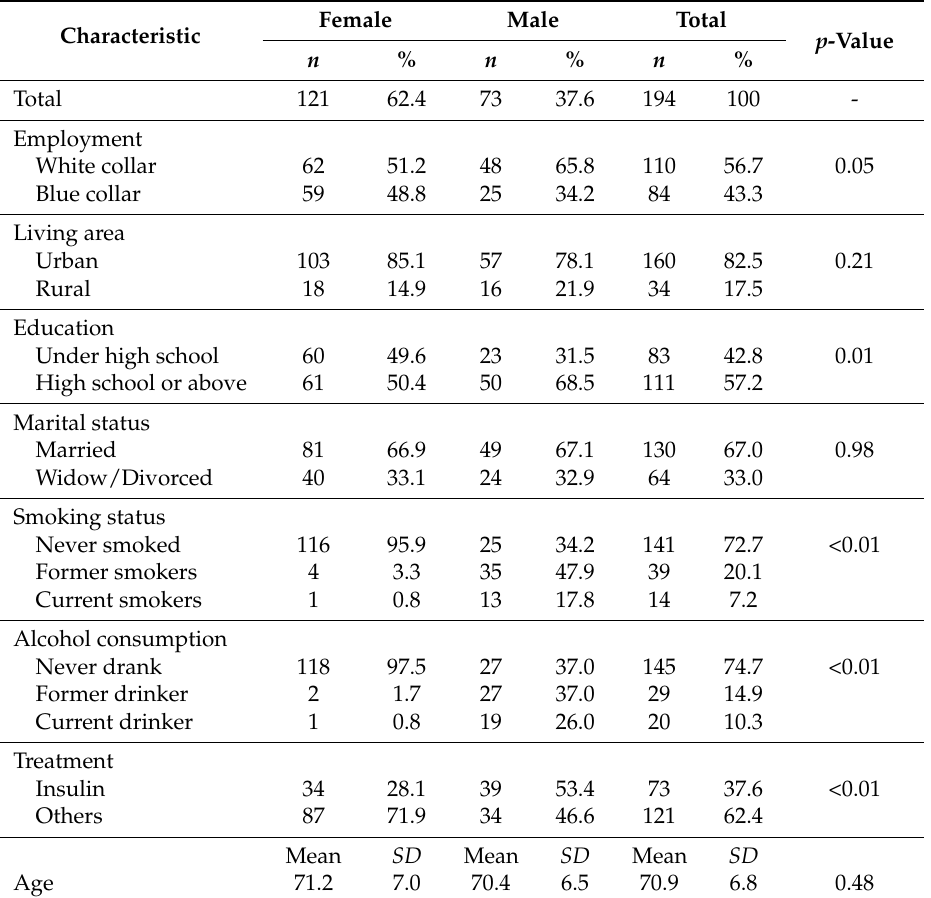
Table 1. Demographic characteristics of respondents.